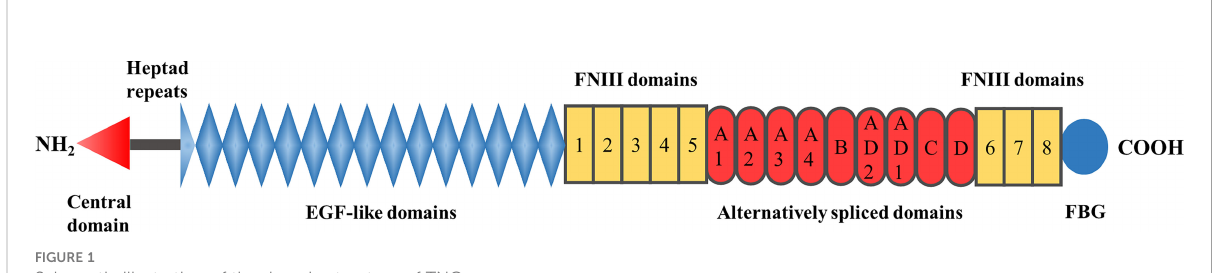
FIGURE 1 Schematic illustration of the domain structure of